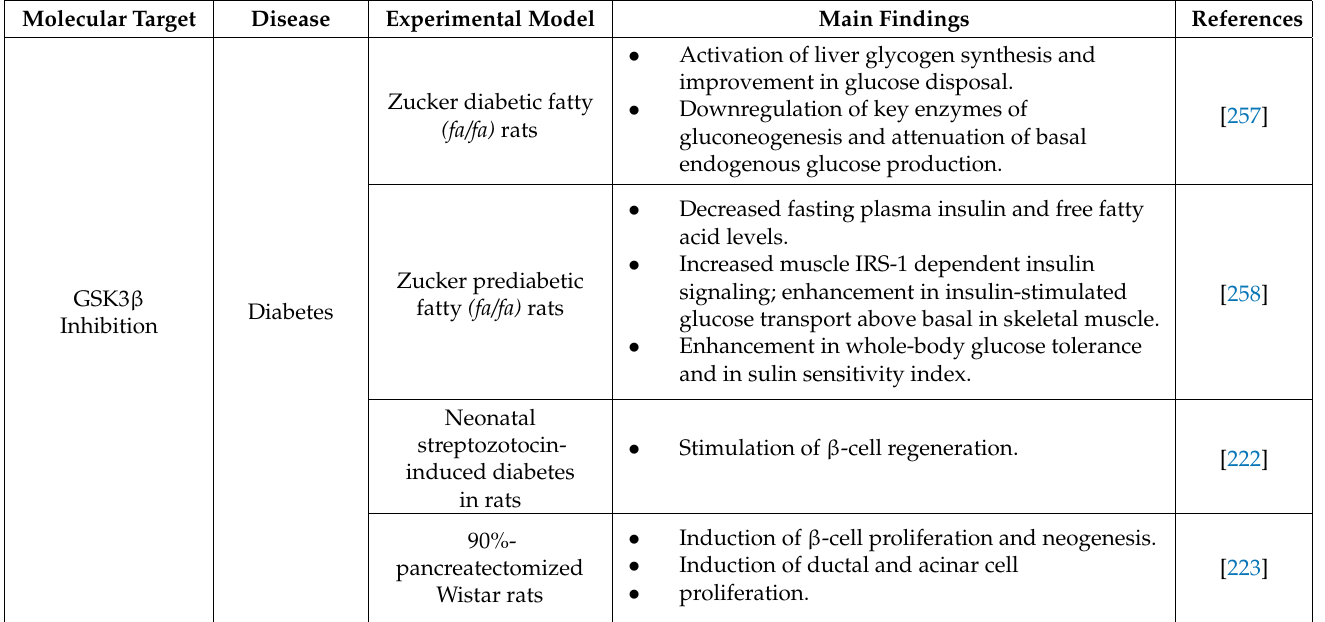
Table 1. Inhibition of GSK3 β as a therapeutic approach for diabetes and